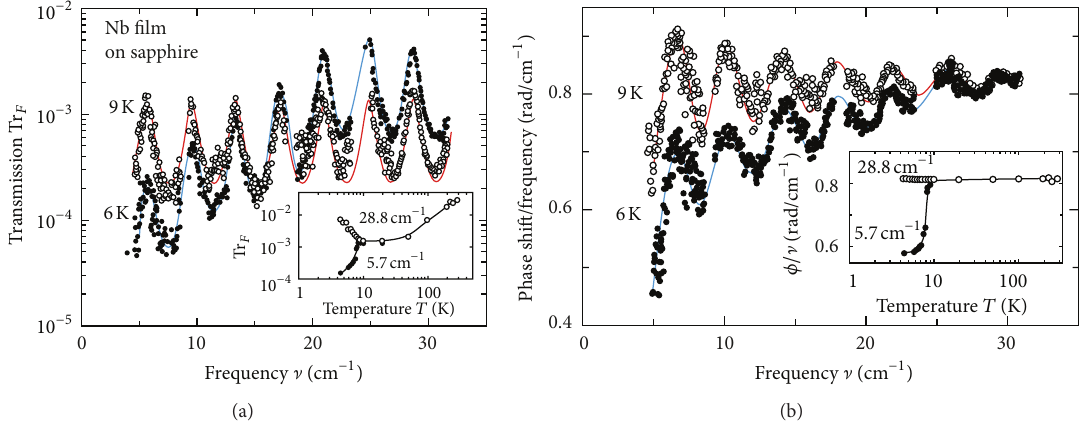
Figure 14: Raw data of transmission Tr (𝜔) and relative phase shift 𝜙( ] )/ ] spectra of the Nb film on the sapphire substrate. The critical temperature is 𝑇 𝑐 = 8.3 K. The phase shift is divided by the frequency ] = 𝜔/2𝜋𝑐 for the better perception. The dots represent the measured values; the red lines for 9K are the fits with the Drude model. The blue lines correspond to the fit using the Mattis-Bardeen equation. In the insets the temperature dependence of Tr and 𝜙/ ] is displayed for two particular frequencies corresponding to the first and last transmission maxima in measured spectral range (after